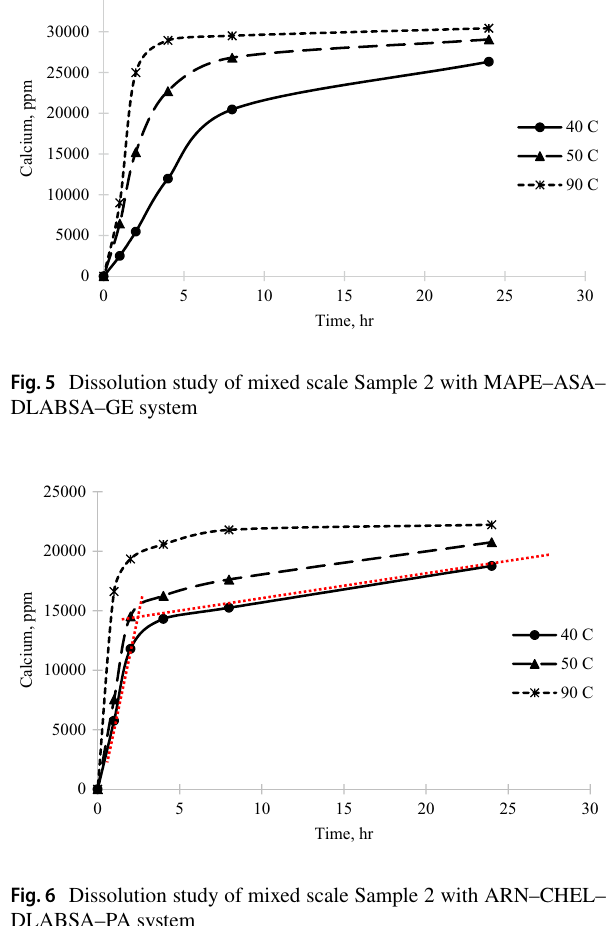
Fig. 6 Dissolution study of mixed scale Sample 2 with ARN–CHEL– DLABSA–PA system